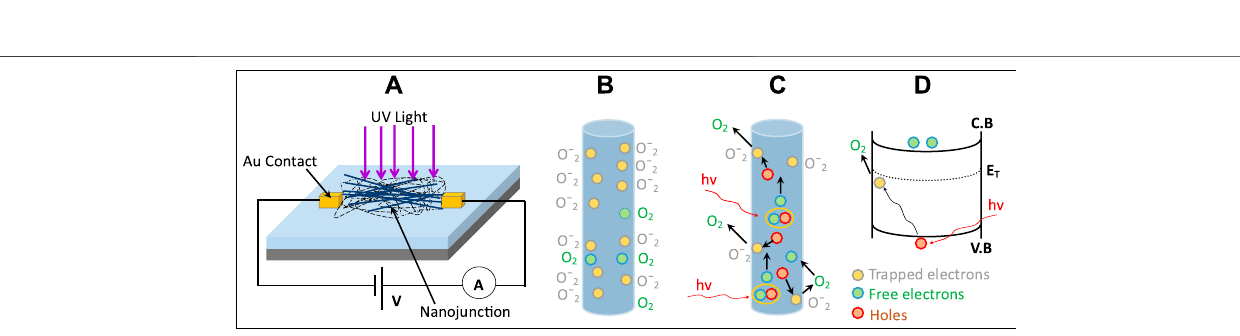
Frontiers in Materials |